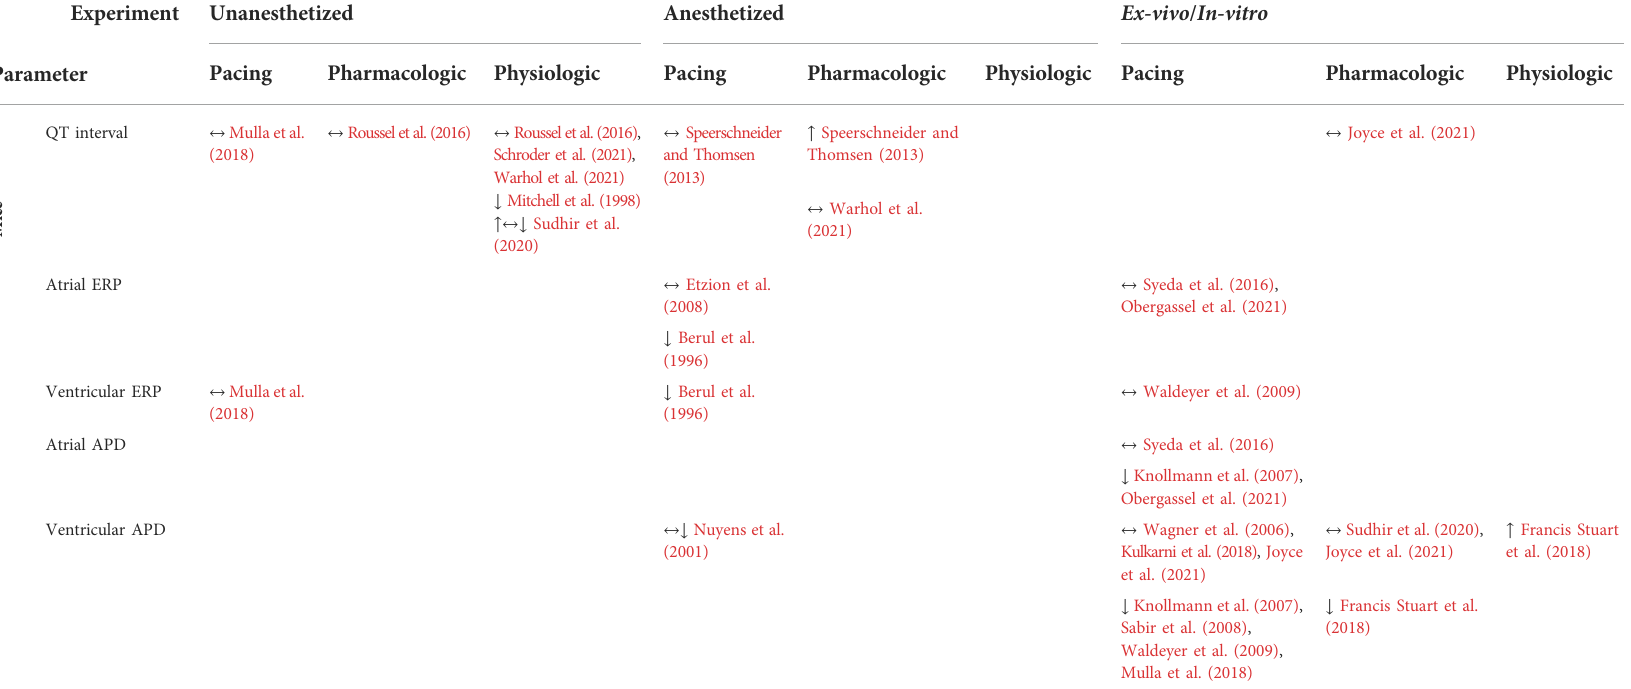
TABLE 1 ( Continued ) Summary of studies in which QT interval, ERP and APD rate relation were evaluated in rats and